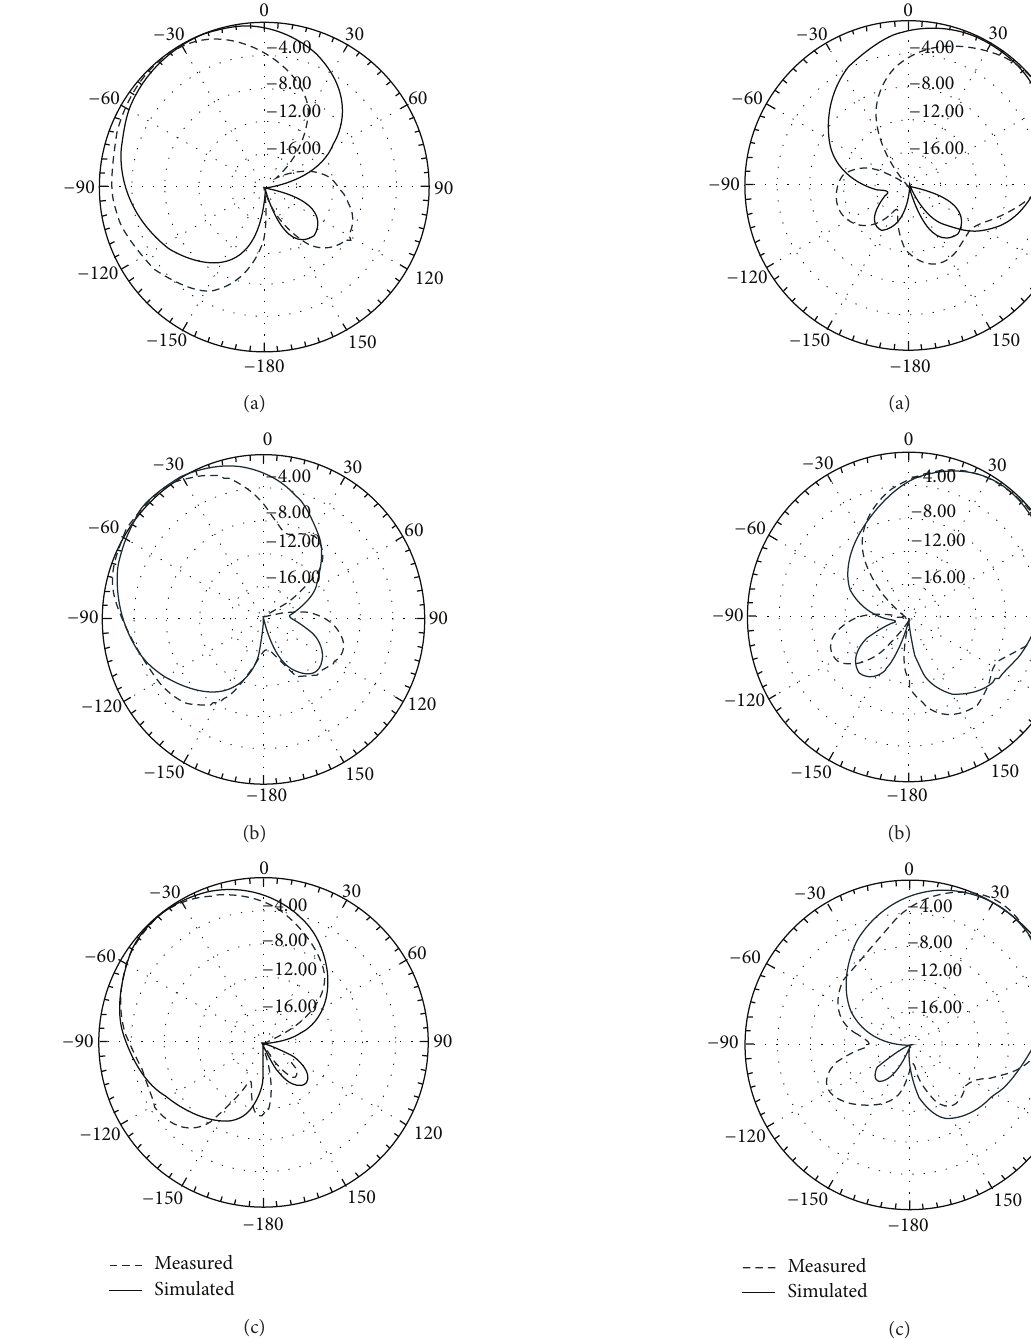
Figure 14: Simulated and measured 2D radiation patterns for Case Figure 15: Simulated and measured 2D radiation patterns for Case I, with 𝑎 = 32 mm, 𝑏 = 29.5 mm, 𝑑 = 48.85 mm, 𝜀 𝑟 = 10 , 𝐿 1 = II, with 𝑎 = 32 mm, 𝑏 = 29.5 mm, 𝑑 = 48.85 mm, 𝜀 𝑟 = 10 , 𝐿 1 = = 5 mm, 𝐿 = 21 mm, 𝑊 = 1.5 mm, 𝑀 = 22 mm, 31 mm, 𝑊 = 5 mm, 𝐿 = 21 mm, 𝑊 = 1.5 mm, 𝑀 = 22 mm, 31 mm, 𝑊 1 2 2 1 1 2 2 1 = 33 mm, 𝑠 = 1.575 mm, 𝑉 = 0.6 mm, 𝑃 = 𝑃 = 2 mm, 𝐿 = 𝑀 = 33 mm, 𝑠 = 1.575 mm, 𝑉 = 0.6 mm, 𝑃 = 𝑃 = 2 mm, 𝐿 = 𝑀 2 𝑊 𝑙 2 𝑊 𝑙 th rad th rad 130 mm, and 𝑊 = 130 mm. (a) 1.3GHz (b) 1.55 GHz (c) 1.75 GHz. 130 mm and 𝑊 = 130 mm. (a) 1.3GHz (b) 1.55 GHz (c) 1.75 GHz. The cross-polar values are too small to be visible in the above scale. The cross-polar values are too small to be visible in the above